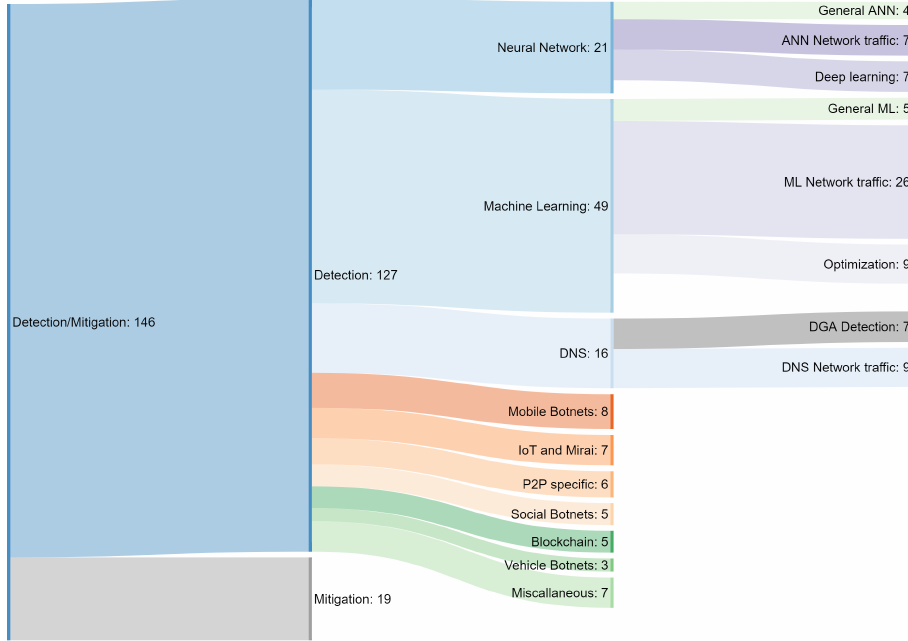
Figure 4. Distribution of botnet detection and mitigation mechanisms for this